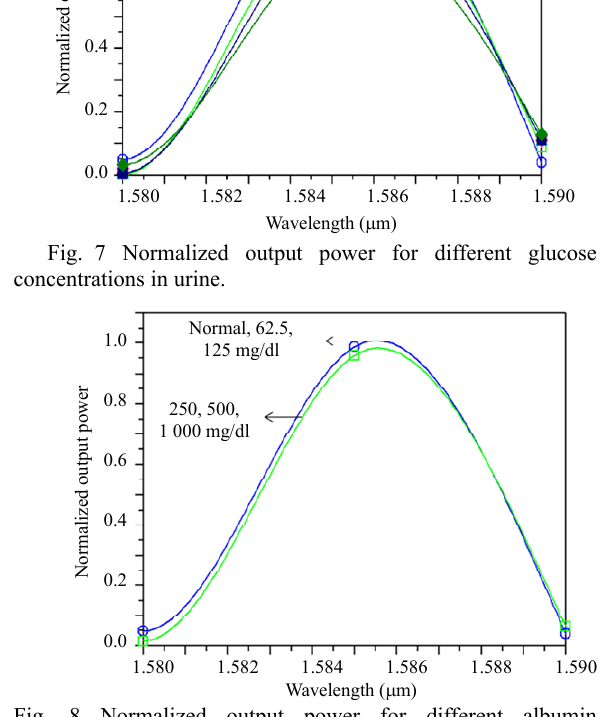
Fig. 8 Normalized output power for different albumin concentrations in